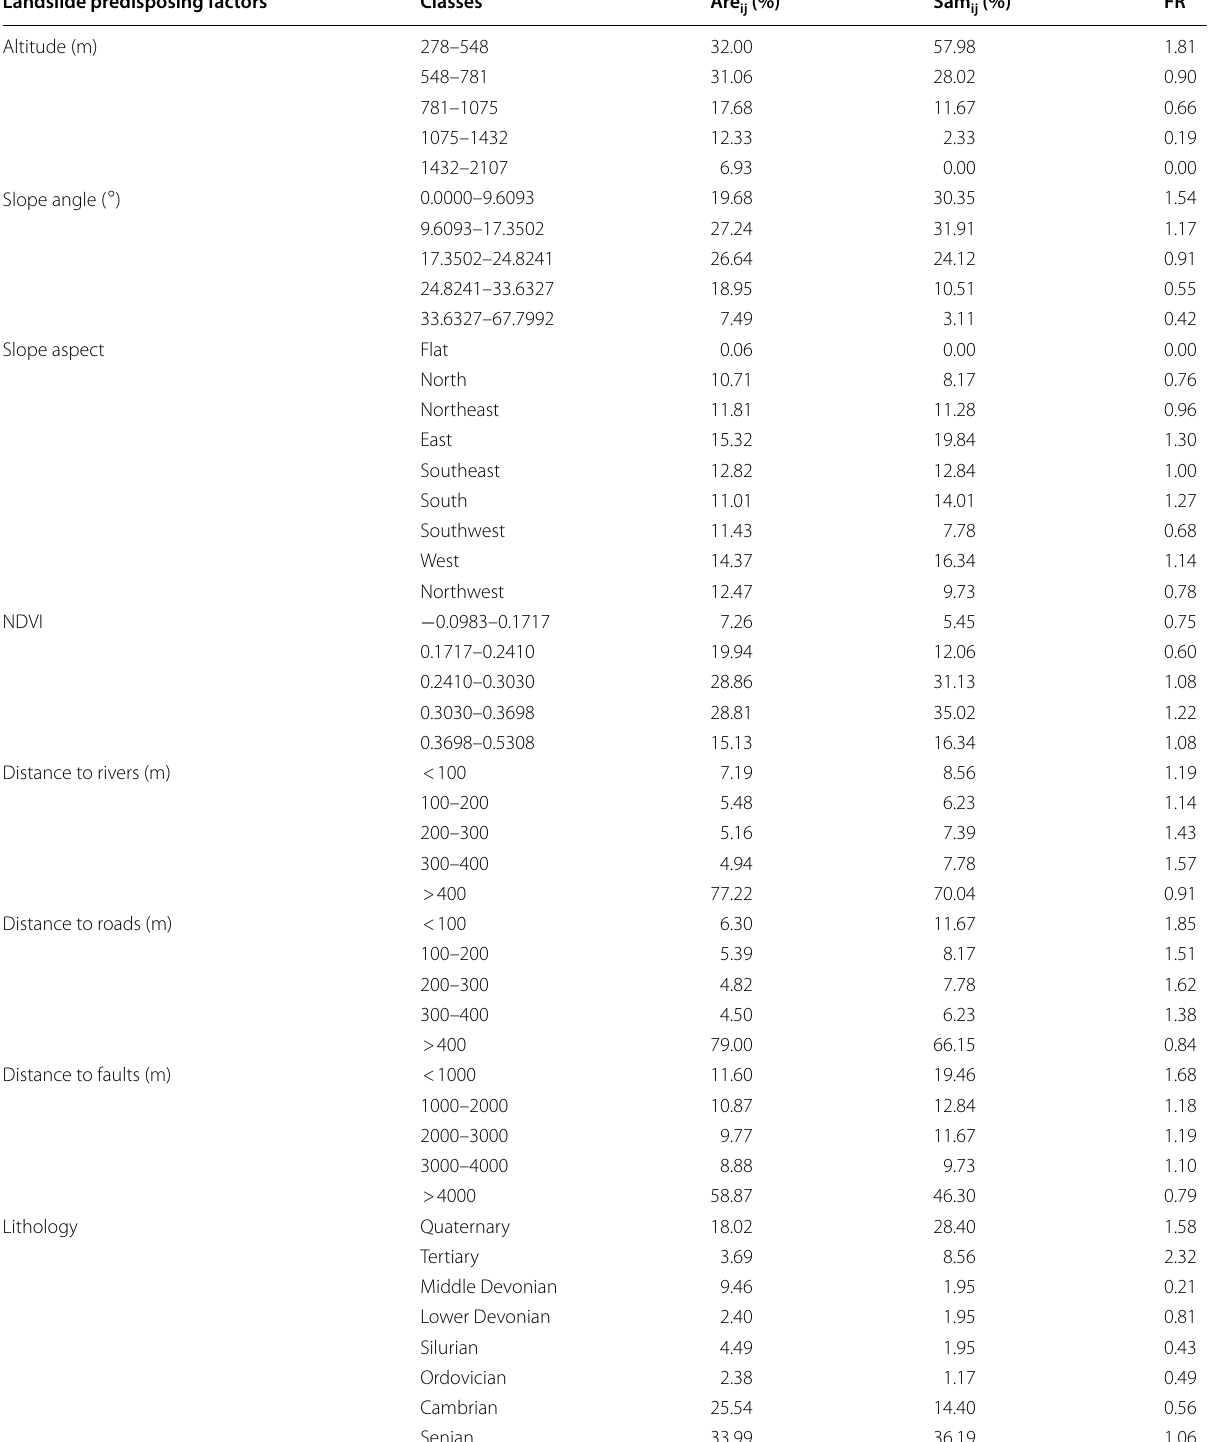
Table 4 The FR calculation result for each class of landslide predisposing factors Landslide predisposing factors Classes Are ij (%) Sam ij (%) FR Altitude (m)